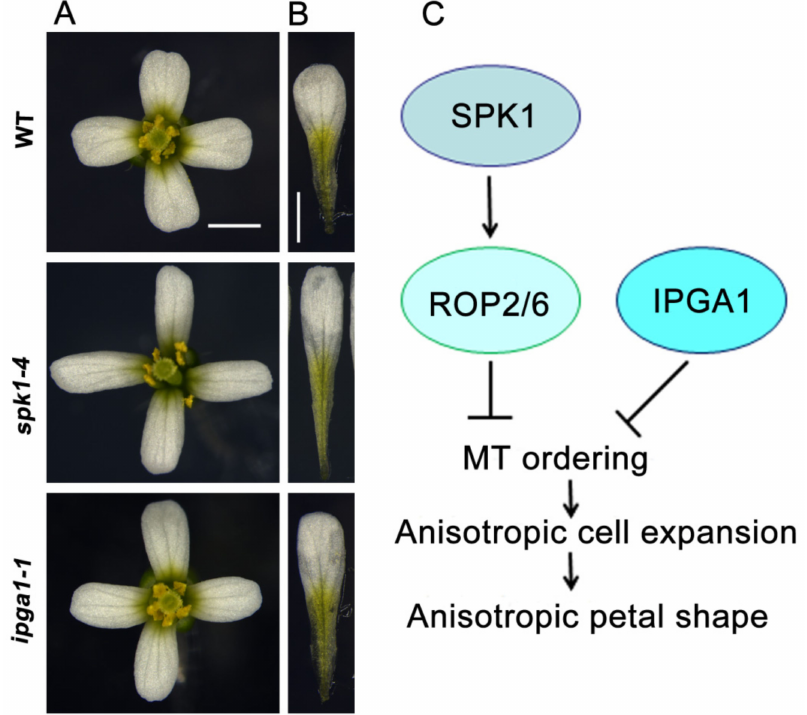
Figure 1. A working model for the regulation of anisotropic petal shape. ( A ) Mature flowers from the wild type, spk1-4 , and ipga1-1 . ( B ) Mature petals from the wild type, spk1-4 , and ipga1-1 . Bars = 1 mm. ( C ) A working model for anisotropic petal shape control. The SPK1-Rho of Plant (ROP) GTPases-microtubule (MT) signaling module and IPGA1-MT module function in petal anisotropic shape, respectively. SPK1 activates ROP2 and ROP6 to inhibit microtubule ordering, resulting in cell anisotropy and petal anisotropy. IPGA1 negatively regulates microtubule ordering, resulting in cell anisotropy and petal anisotropy. The arrows indicate positive regulation, and the perpendicular lines indicate negative